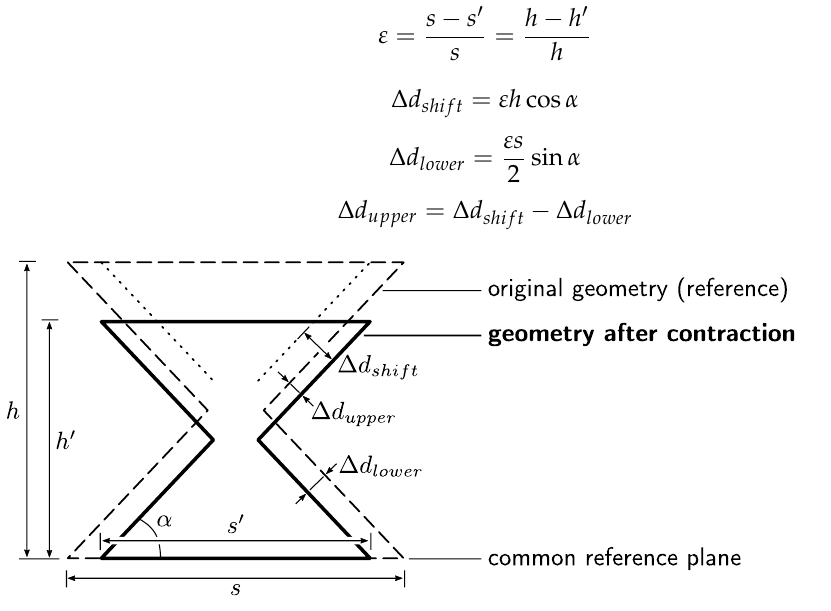
Figure A2. Effect of data registration on the calculated accuracy of the geometry of part B. The alignment of the objects to the bottom side creates an additional